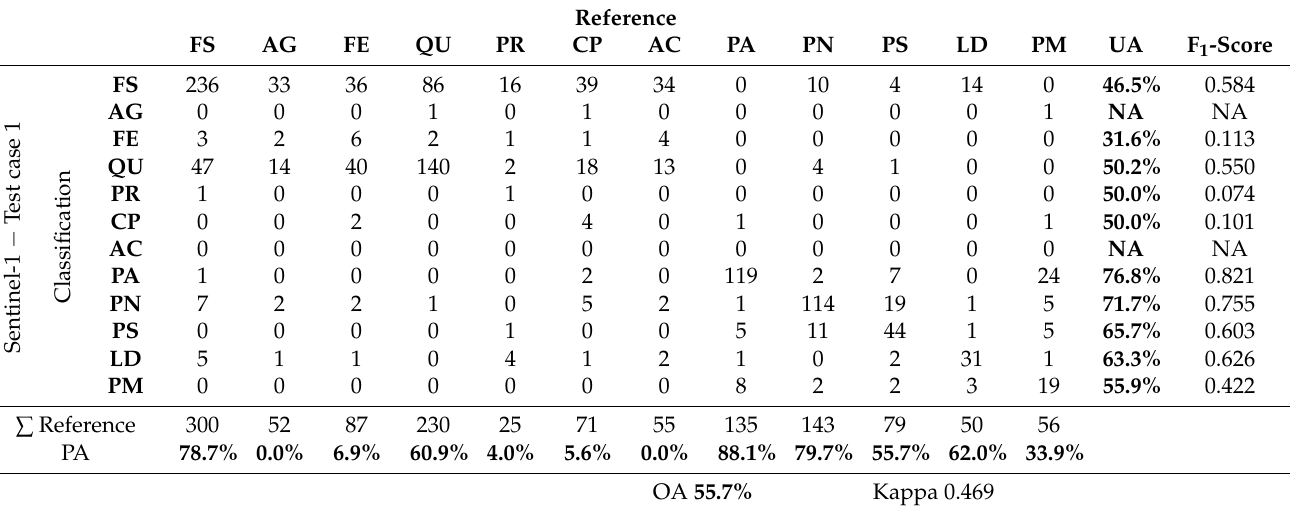
Table 6. Confusion matrix based on the out-of-bag-result of Test case 1, using only Sentinel-1 data. UA: user’s accuracy, PA: producer’s accuracy, OA: overall accuracy; for the abbreviations of tree species names see Figure 1.